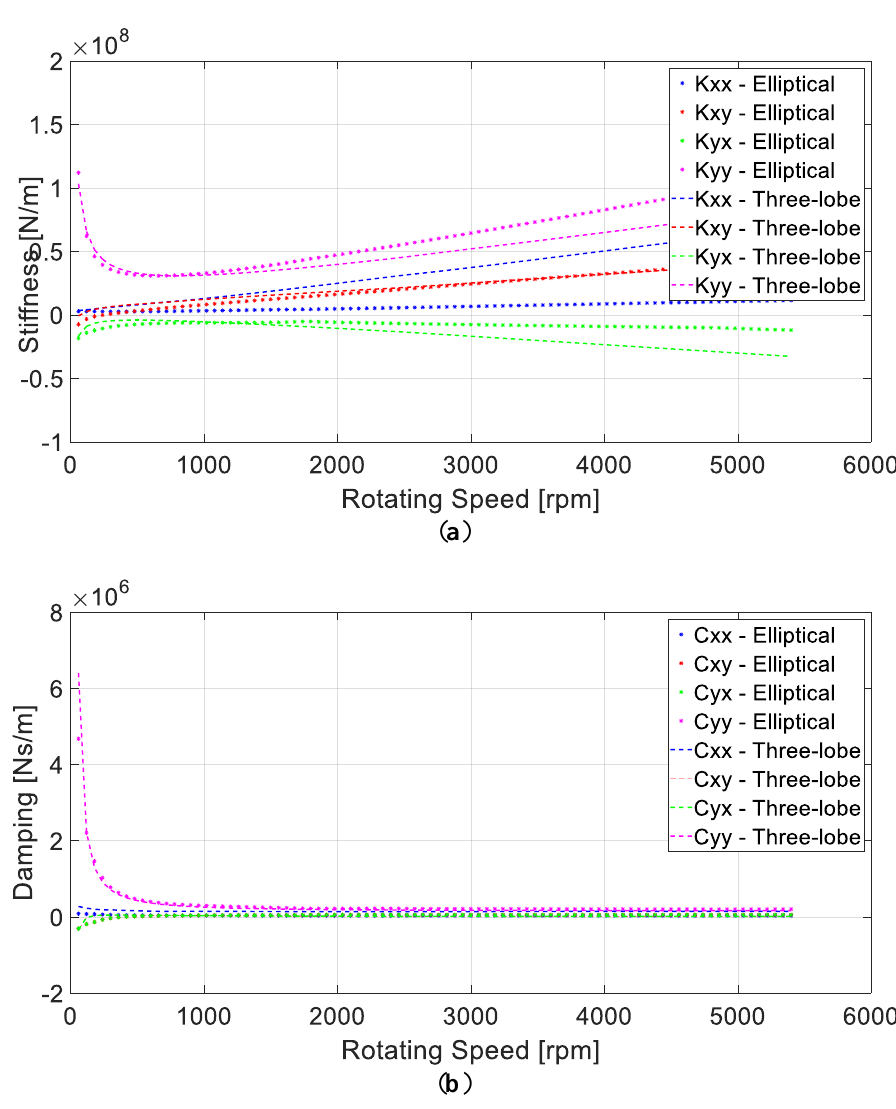
Figure 4. Dynamic Coefficients for elliptical and three-lobe bearings — ( a ) Stiffness; ( b ) Damping.